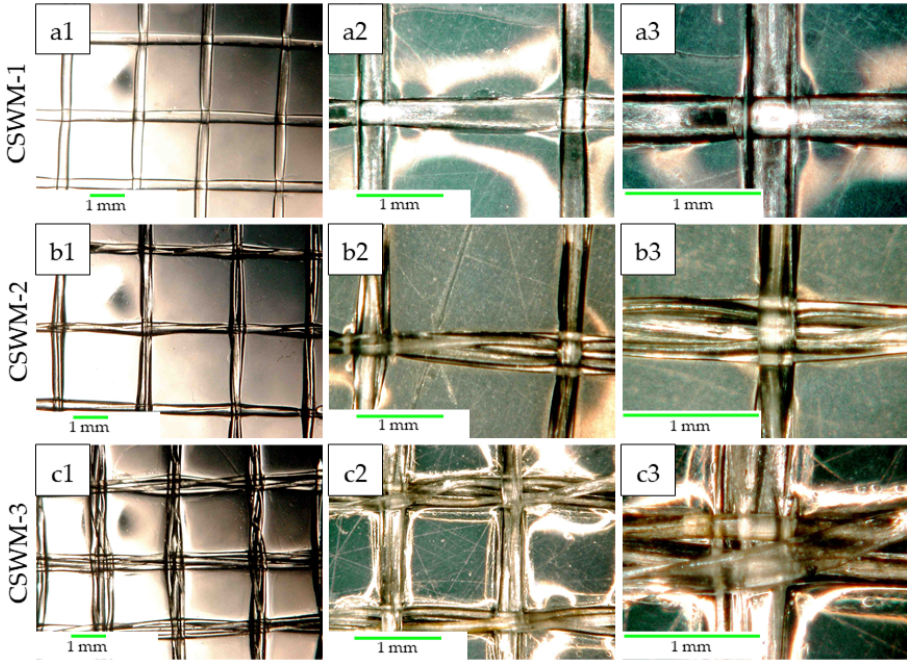
Figure 5. Optical microscopy (OM) micrographs of the chitosan woven meshes obtained by weaving: ( a1–a3 ) Monofilament composed; ( b1–b3 ) two-filament composed; and ( c1–c3 ) three-filament composed.